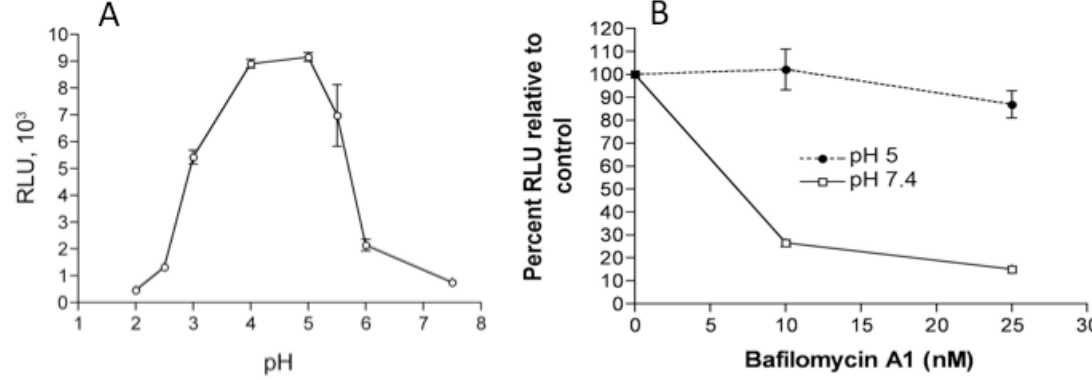
Figure 3. Effects of low pH and inhibitors of endosomal acidification on VACV MV entry. ( A ) Following adsorption of a recombinant VACV MV that expresses firefly luciferase at 4 °C, cells were incubated with buffers at the indicated pH for 3 min at 37 °C. The cells were then incubated with regular medium for 1 h at 37 °C, lysed and luciferase activity measured; ( B ) Cells were pretreated with indicated concentrations of bafilomycin A1 for 50 min at 37 °C and then infected with MVs, briefly exposed to pH 5 or 7.4 buffer, and luciferase activity measured as in panel A. Note that incubation at pH 5 allows fusion at the plasma membrane and bypasses the effect of the inhibitor. Modified from reference